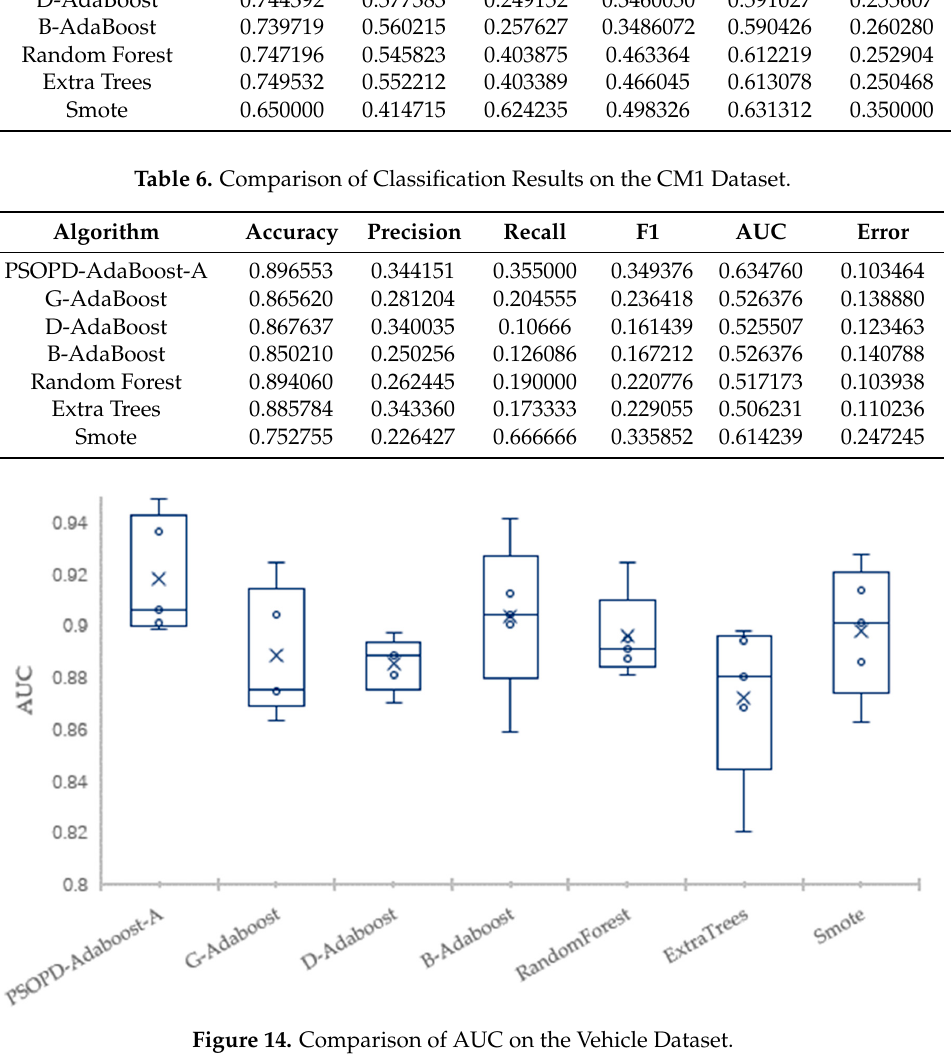
Figure 14. Comparison of AUC on the Vehicle